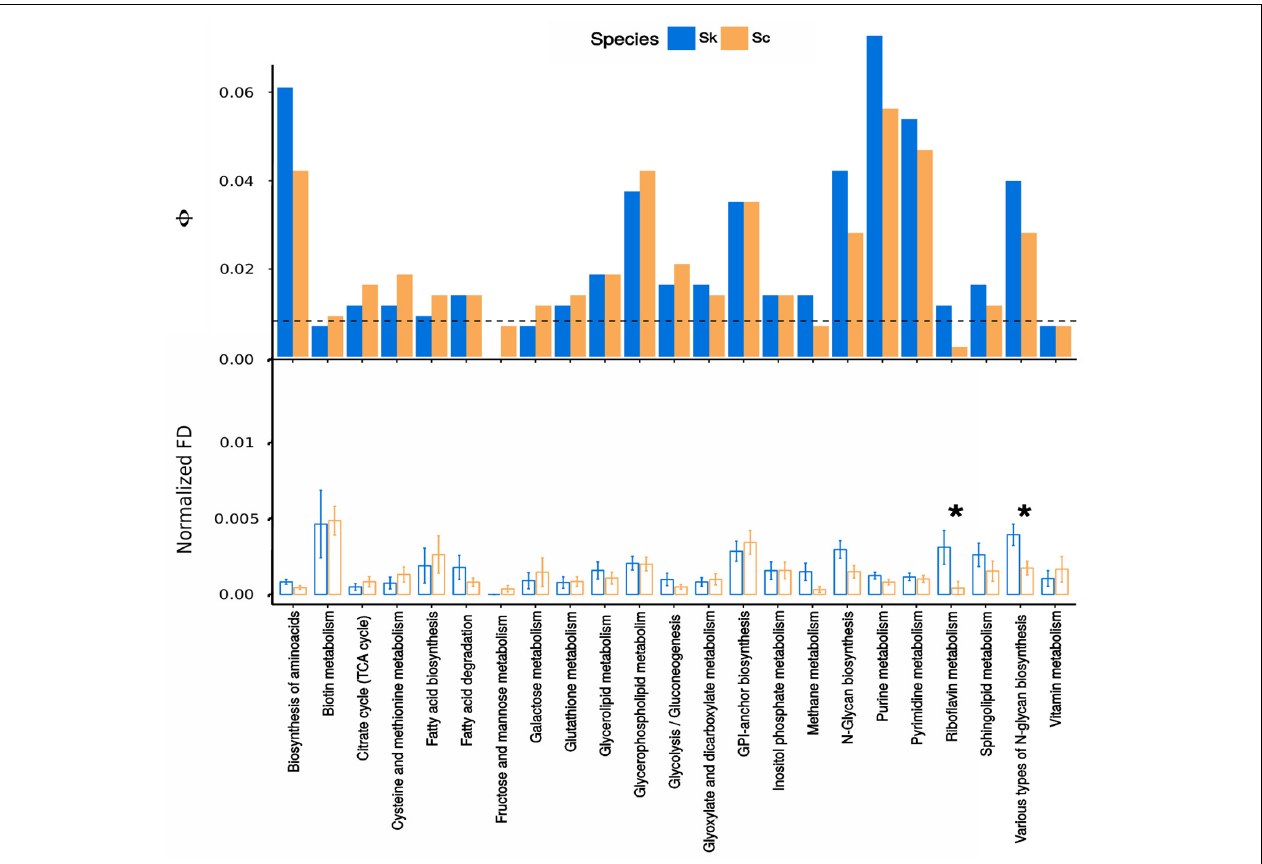
FIGURE 3 | Functional divergence among a subset of metabolic pathways. (Top panel) Normalized contribution of genes showing evidence of functional divergence to every path. The height of the bars represents (cid:56) , the normalized contribution of each pathway ( i ) of size ( t ) to the total number of genes under functional divergence when considering the whole dataset ( T ), calculated as (cid:56) = ( n i / t ) ( t / T ). Bars above the dashed line represent enriched pathways in genes under functional divergence while bars below the line show impoverished pathways. (Bottom panel) Normalized functional divergence values among metabolic pathways. The significance of the differences in every pathway between analysis performed with Sk or Sc as clade-of-interest was assessed by a Wilcoxon paired signed-rank test, those significant were indicated with an asterisk.